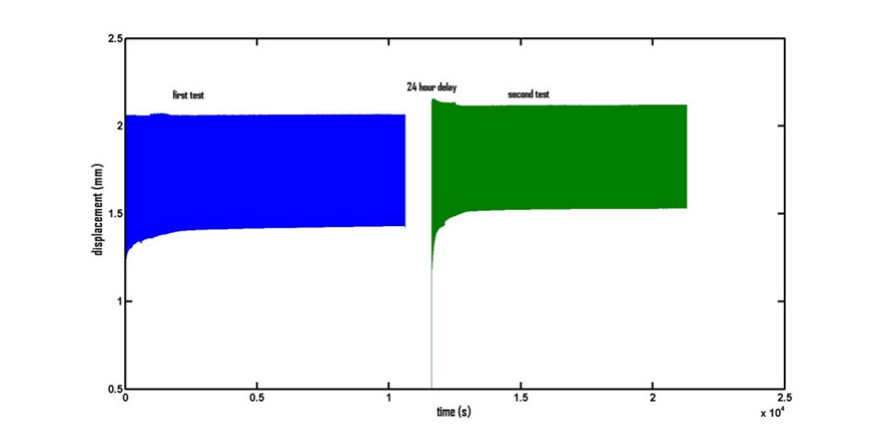
Fig. 5 Results of test with a hold time of 0.1 s and interruption of 24 hours in the middle of the test.